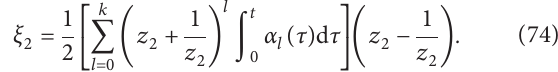
� 0 . 8, z � 0 . 9, and z 1 2